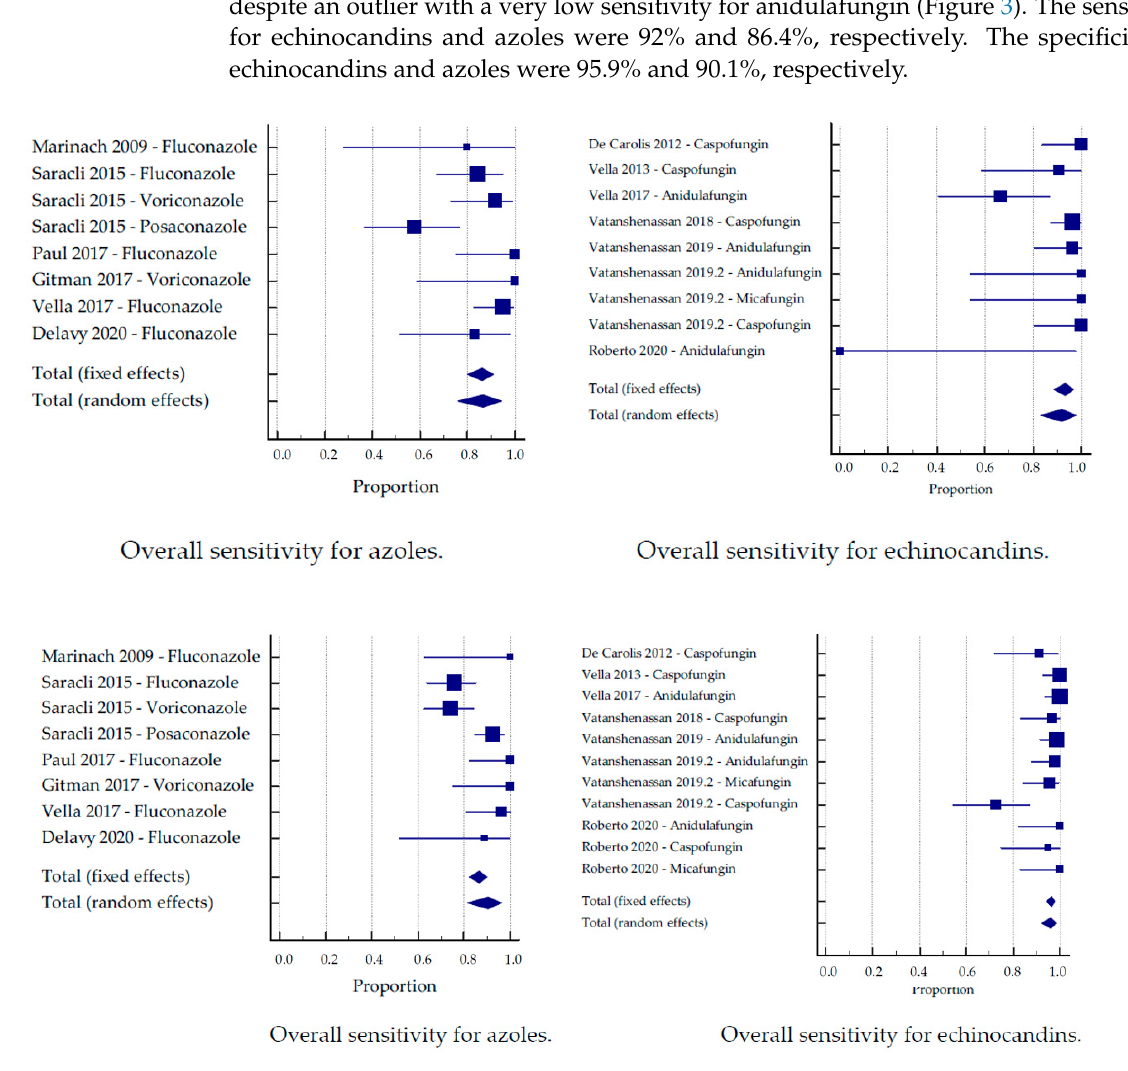
approach, no significant difference in sensitivity between the two antifungal groups could